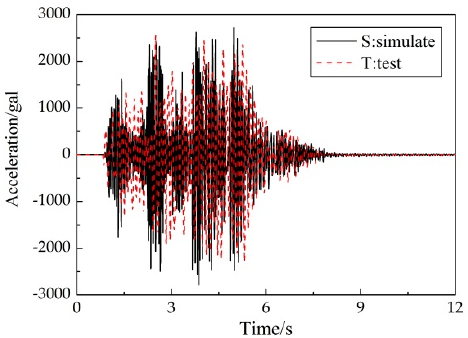
Figure 8. Comparison of roof-acceleration response under Sy-2 condition.